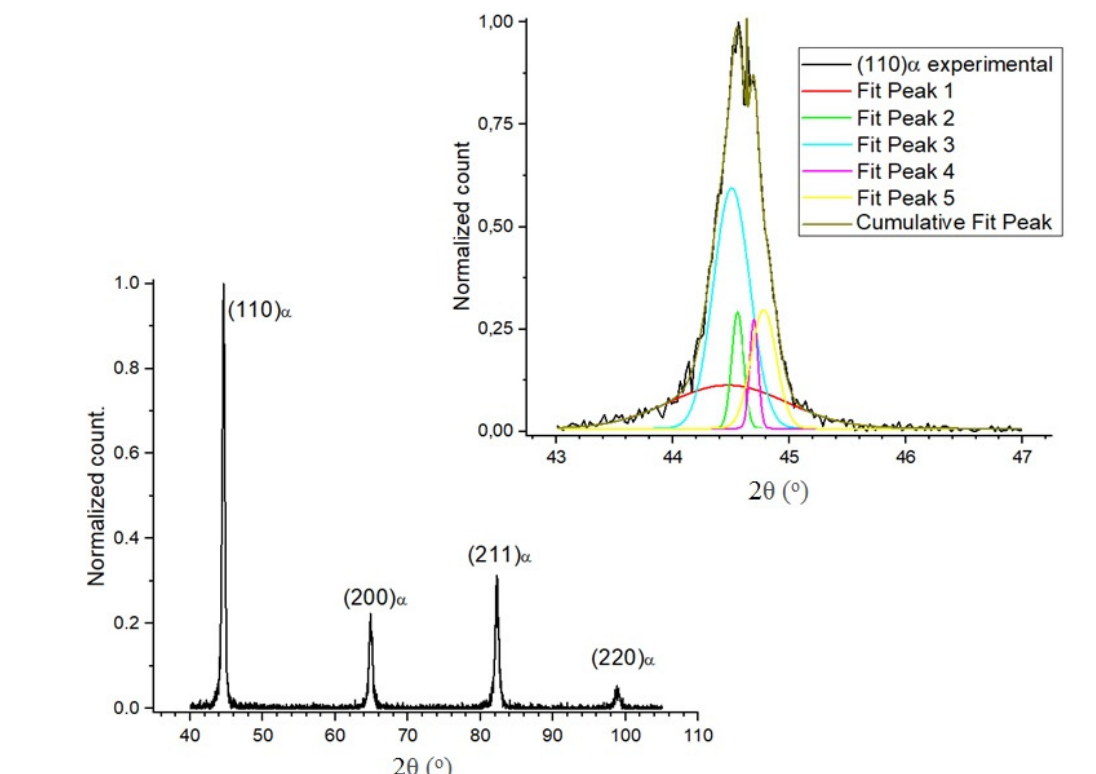
Figure 2. XRD patterns of the investigated specimen. Table 1. Peak parameters such as crystallite size (D), dislocation density ( δ ), micro-strain ( ε ) for five sub-peaks using the self-made numerical process of Gaussian multiple of as-received specimen.